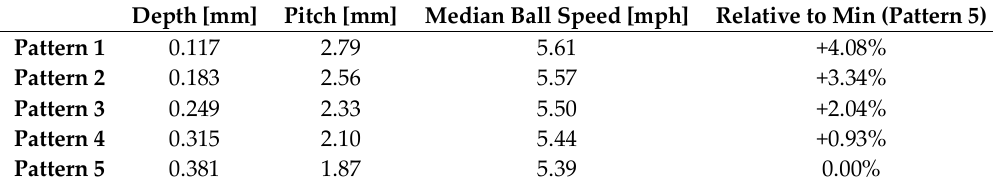
Table 1. Ball speed of putters tested with different face milling patterns.